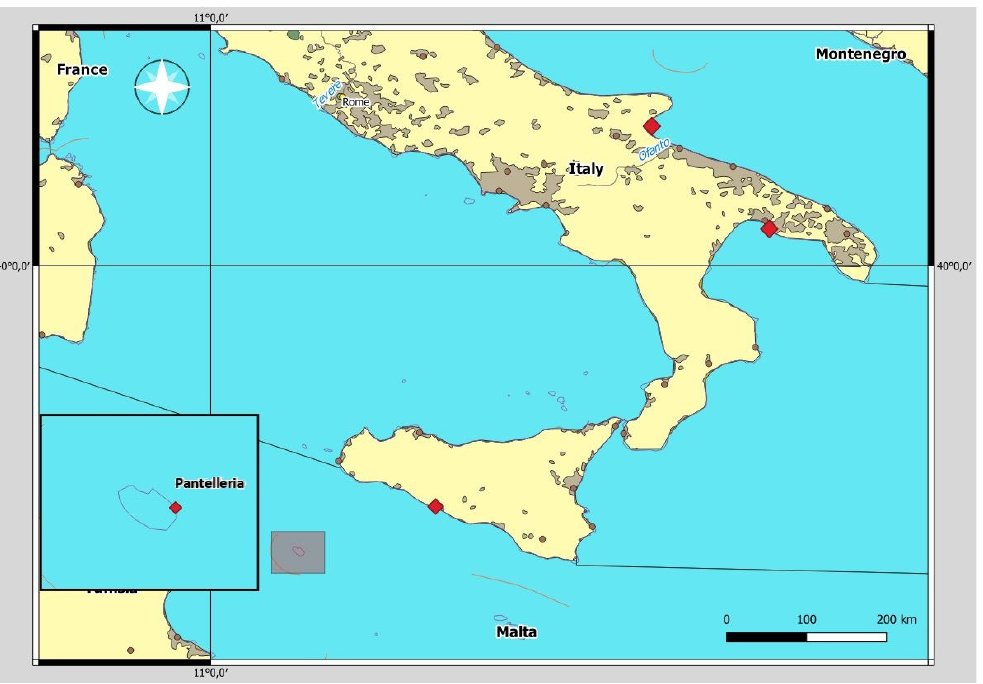
Figure 1. Map of the sites where the great cormorants ( P. carbo sinensis ) examined were collected.